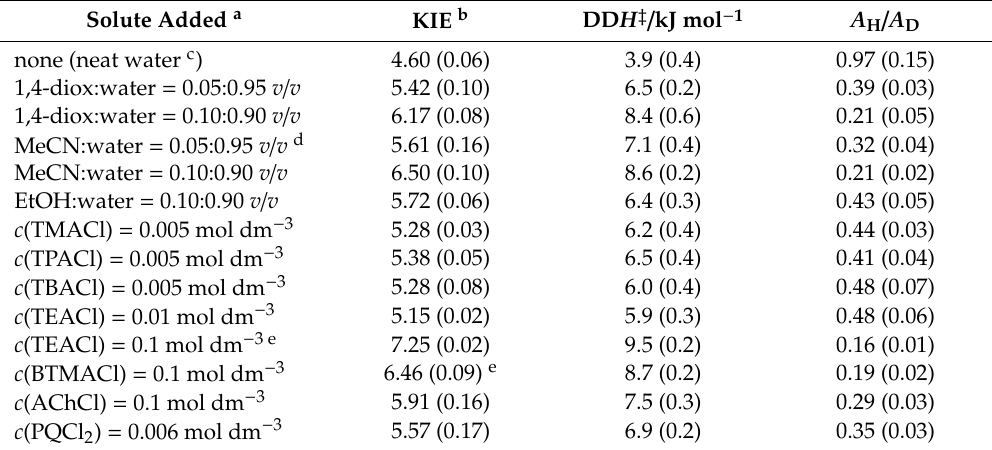
Table 1. Kinetic Isotope Effects, Isotopic Differences ΔΔ H ‡ (D,H) and Ratios A H / A D in the Reaction of Ascorbate with Hexacyanoferrate(III) Ions (Scheme 1).